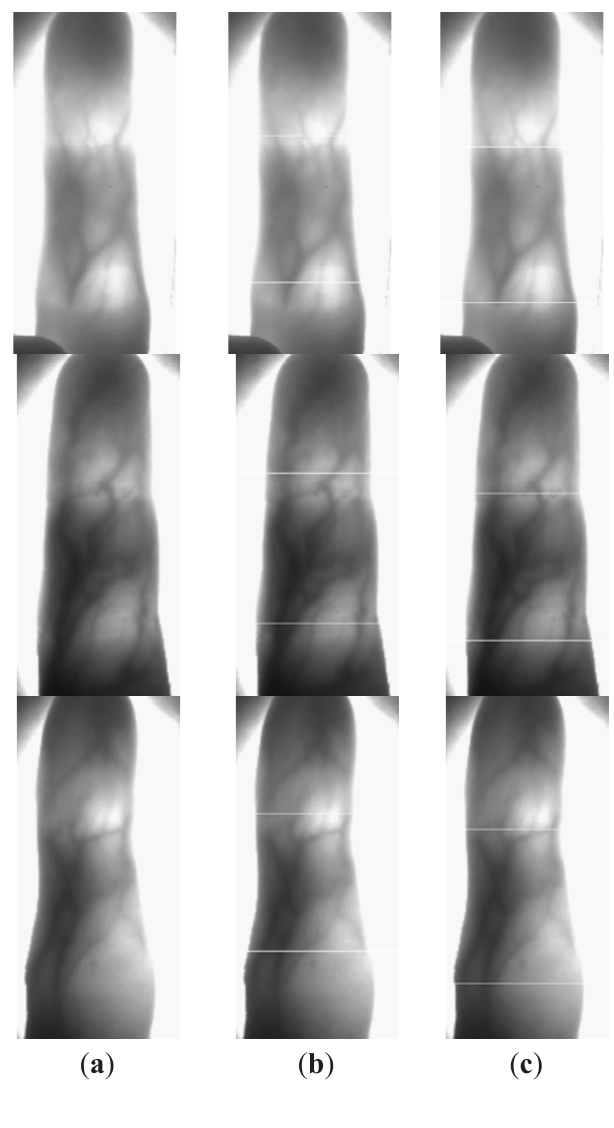
Figure 8. The positions of two phalangeal joints in the finger vein image. ( a ) The original finger vein image. ( b ) The positions of two phalangeal joints detected by the method in [6] ( (cid:70) ) The positions of two phalangeal joints detected by our